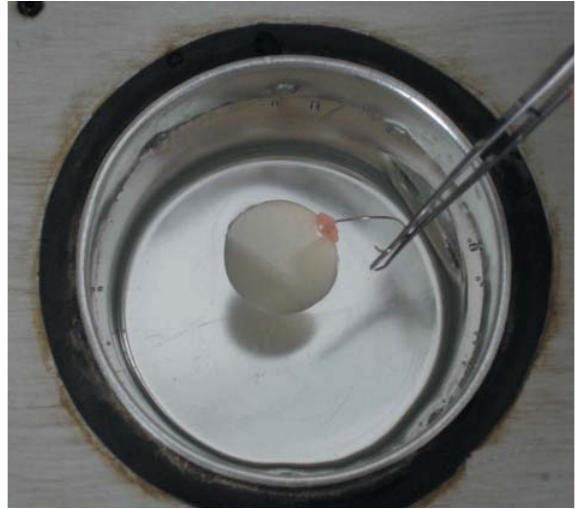
Figure 3- Chemical